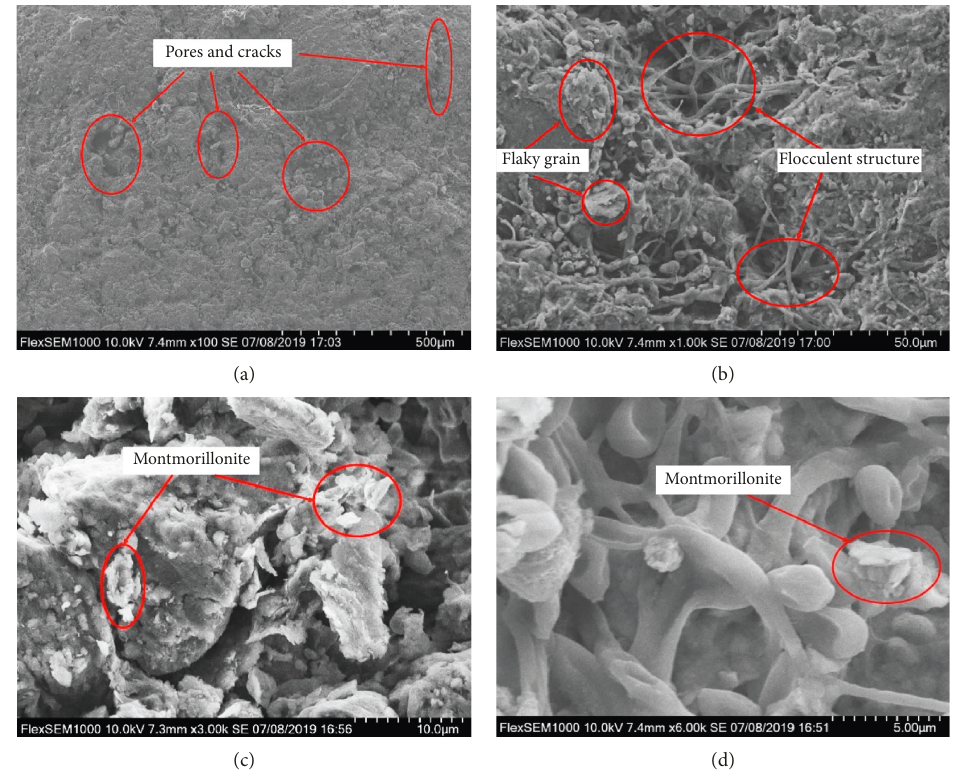
Figure 19: SEM images of plain soil under different magnification multiples (28 days). (a) × 100; (b) × 1000; (c) × 3000; (d) ×